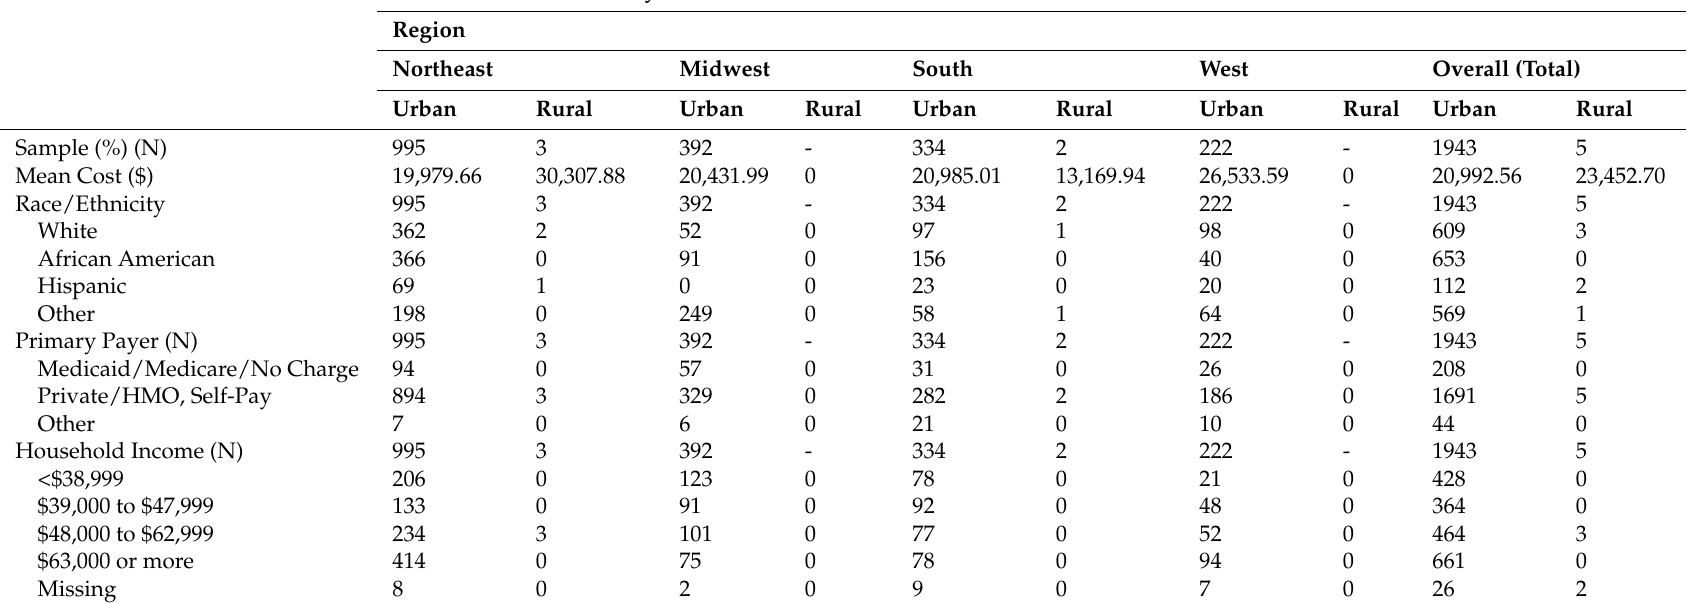
Table 1. Regional Distribution of Uterine Artery Embolization (UAE) by Cost, Length of Stay, Race/Ethnicity, Adverse Complications, Primary Payer, Household Income and Patient Referral Source in the United States between 2004 and